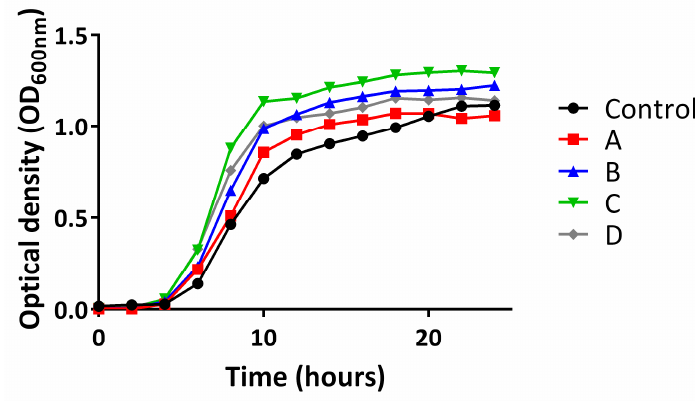
Figure 14. Growth curves of the silver-free polymers at 1 mg/mL against E. coli (Control).